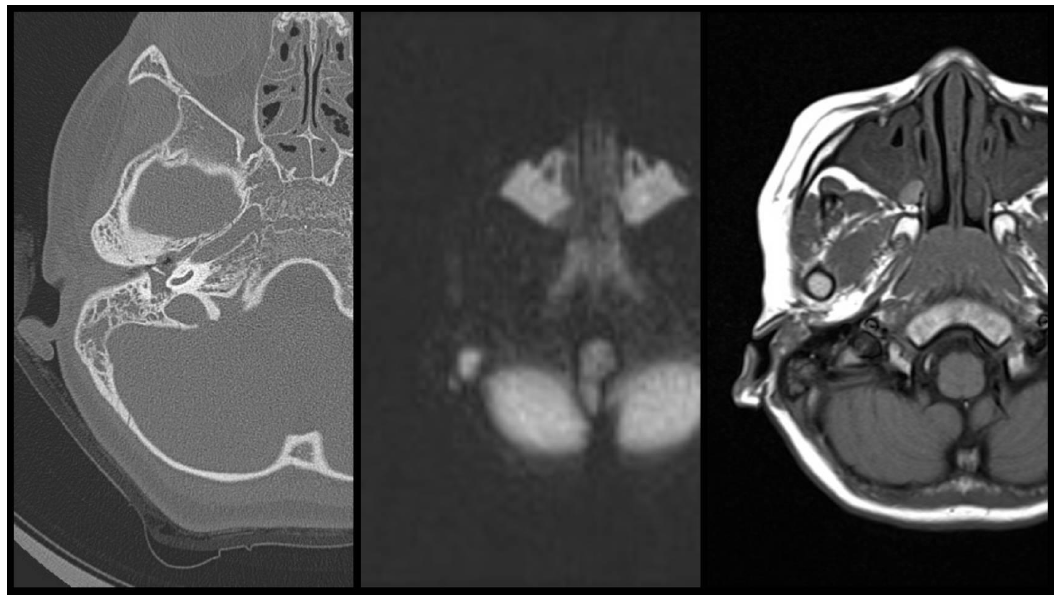
Figure 2. DW-T1W-CT images of false negative case (case 24). From left to right, CT-DWI-T1.